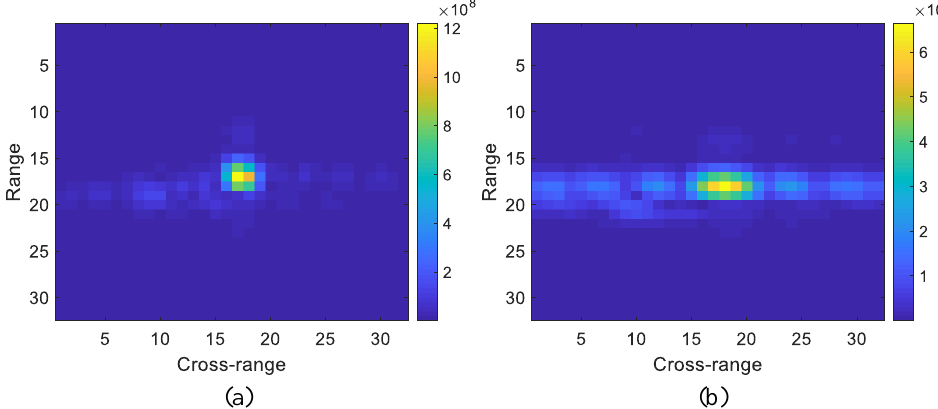
Figure 16. The envelope of T3. ( a ) Before correction. ( b ) After correction.